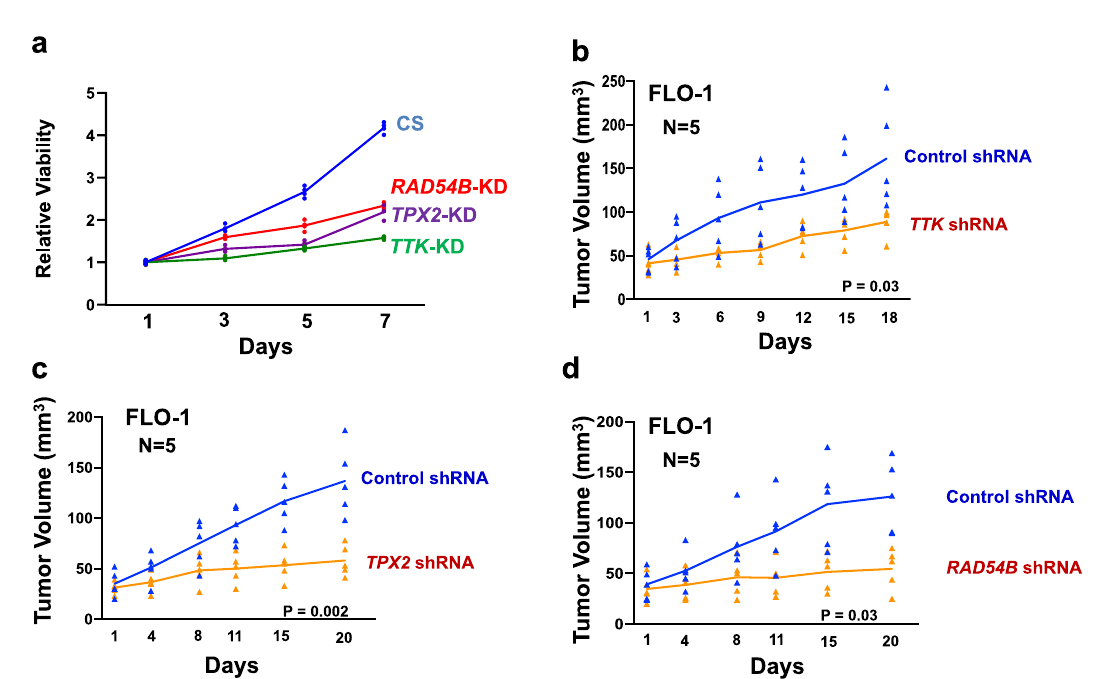
Fig. 4 Suppression of TTK , TPX2 , or RAD54B impairs EAC cell growth in vitro and in vivo. a Control and knockdown FLO-1 cells were cultured and cell viability assessed at various intervals. b – d Control and knockdown FLO-1 cells, cultured for >10 days in vitro, were subcutaneously injected in SCID mice and tumor growth measured at indicated intervals. Error bars indicate SEMs of tumor sizes in different mice. Two-tailed p -values derived by Student ’ s t - test ≤ (Fig. 6c) and cisplatin (Fig. 6d). Combination index plots (Fig. 6e) Importantly, the addition of TTK inhibitor caused a marked show that TTK inhibitor synergistically increased the cytotoxicity ( fi vefold) inhibition/reduction of etoposide-induced DNA breaks of both chemotherapeutic agents in both cell lines tested. In and DNA end resection (as assessed from p-RPA32 expression) summary, these data show that TTK inhibitor inhibits EAC cell (Fig. 7b; full blots shown in Fig. 7b of Supplementary Data 2). growth both in vitro and in vivo, and synergistically increases the EAC cell lines treated with TTK inhibitor and/or etoposide were ef fi cacy of chemotherapeutic agents. also evaluated for impact on micronuclei, a marker of genomic instability. In FLO-1 cells, etoposide caused an increase in the micronuclei (by 12-fold), whereas a low dose of TTK inhibitor caused ~3.0-fold reduction in etoposide-induced micronuclei (Fig. 7c, d). Similarly, in OE19 cells, etoposide caused an increase in micronuclei (by 5.7-fold), whereas treatment with a low dose of TTK inhibitor not only inhibited spontaneous micronuclei (by 2- fold) but also caused 2.6-fold reduction in etoposide-induced micronuclei (Fig. 7e, f). A similar impact of these treatments was also observed on acquisition of copy number events in EAC (FLO-1) cells. FLO-1 cells were treated with TTK inhibitor, eto- poside, and a combination of both drugs for 3 weeks, and the acquisition of copy number changes relative to “ Day 0 ” cells (representing baseline genome) monitored, using Axiom ™